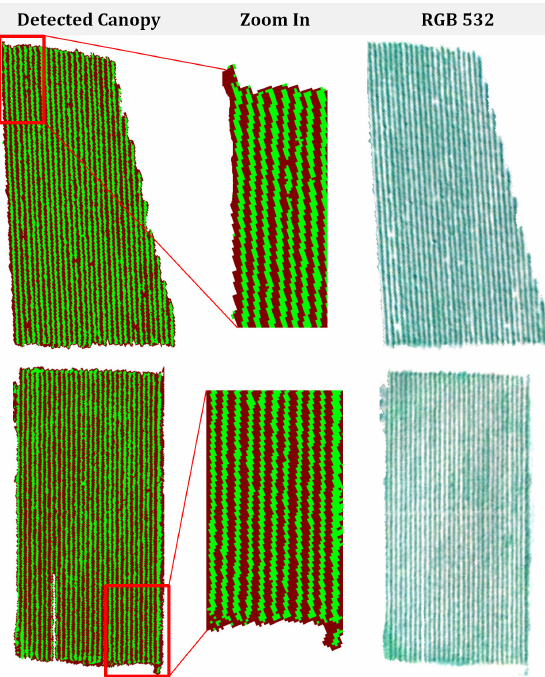
Figure 4. The extracted vine canopy with green color and the detected in-between the rows materials, e.g., soil, with brown on two vine parcels. The corresponding natural color composites are also presented